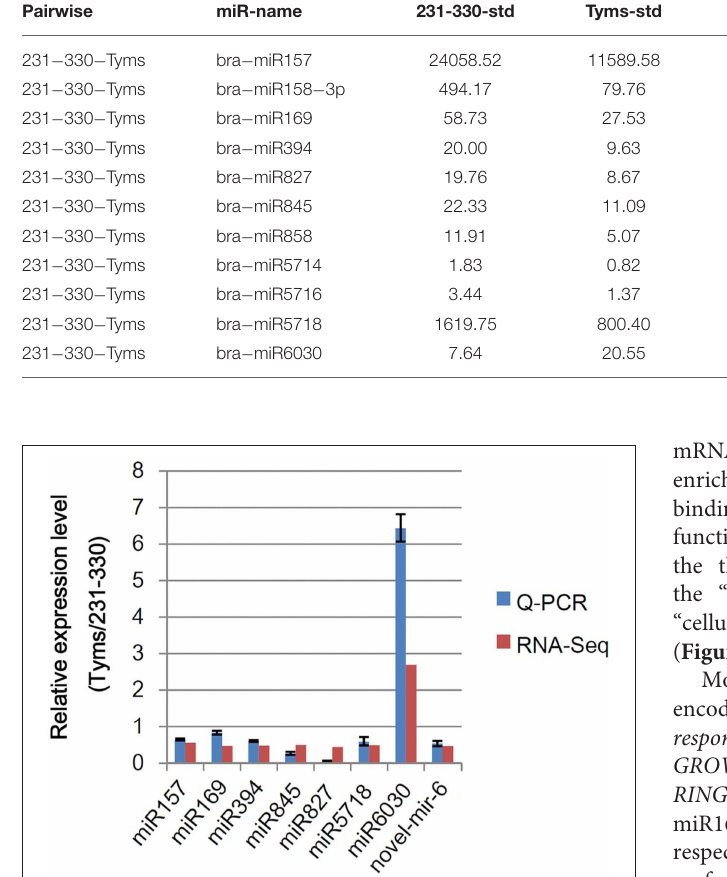
TABLE 3 | Differentially expressed known miRNAs. Pairwise